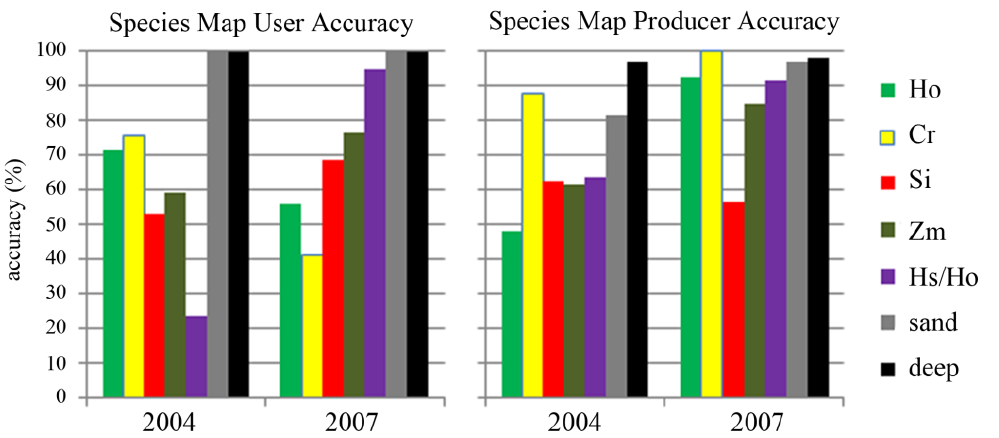
Figure 8 . User (left) and Producer (right) accuracy values for the 2004 and 2007 seagrass species maps. Legend abbr. Ho = Halophila ovalis, Cr = Cymodocea